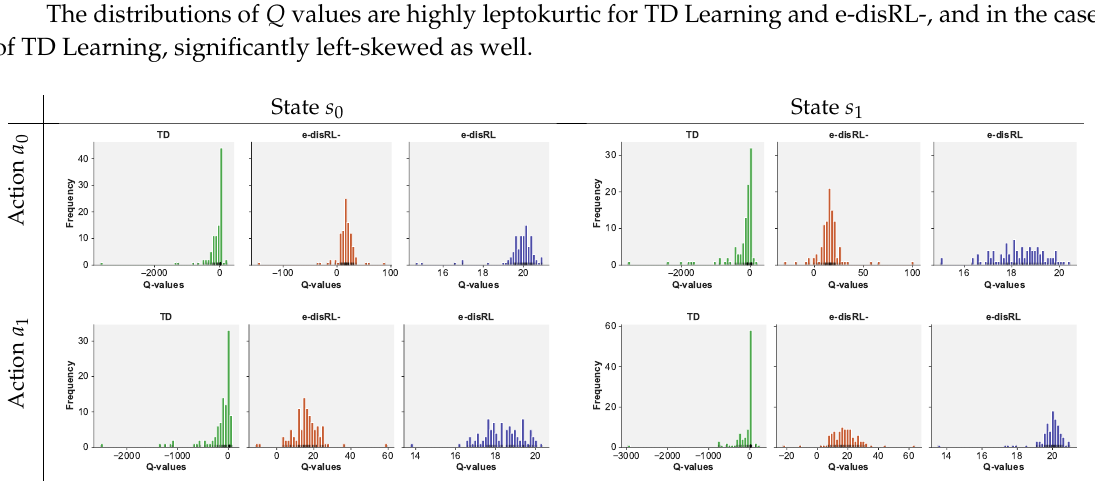
Figure 5. Histograms of estimated Q values at the end of episode 200 in 100 game plays. TD Learning, e-disRL- and e-disRL. The effect of tail risk is marked under TD Learning, and is still quite noticeable when decoupling the immediate reward in the prediction error while estimating its mean using the sample average of past rewards (e-disRL-). Only when an efficient estimator of the mean is used (e-disRL) does the effect of tail risk